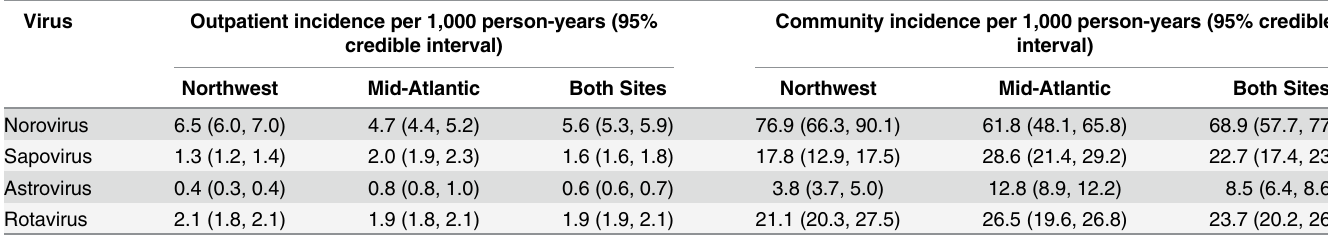
Table 2. Outpatient and community incidence of viral pathogens that cause AGE, by